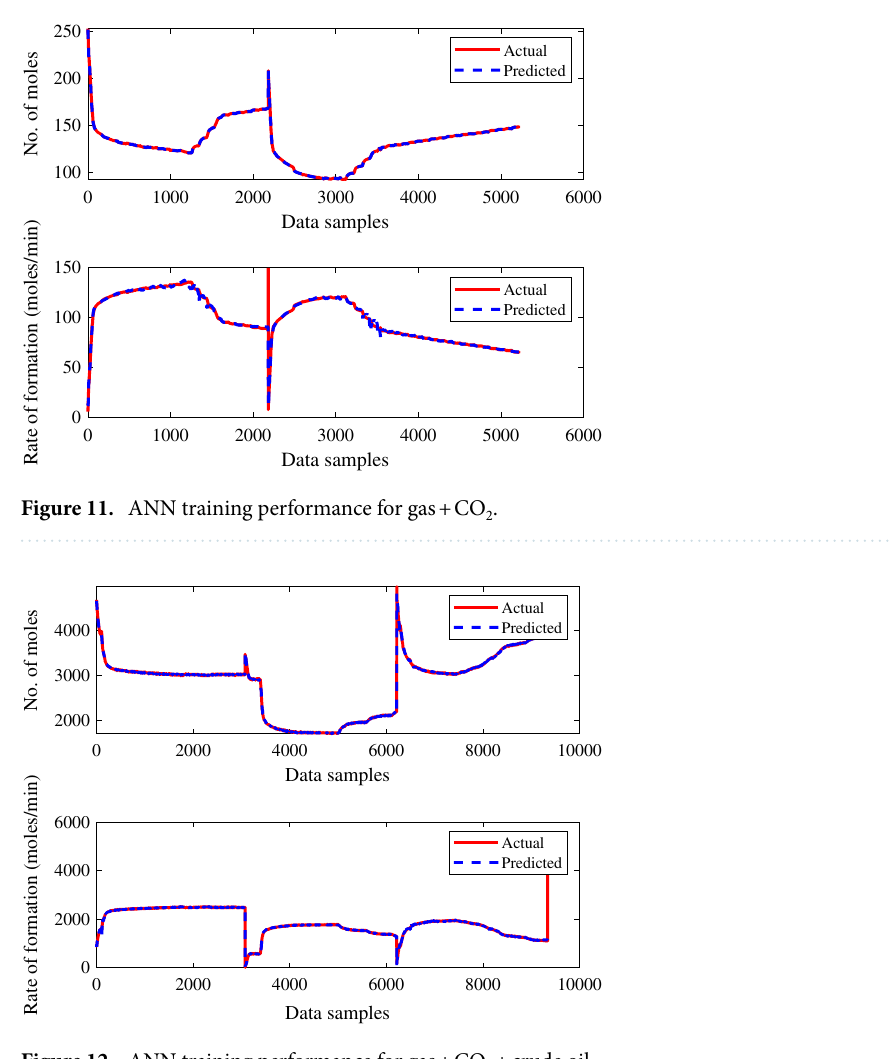
Figure 12. ANN training performance for gas + CO 2 + crude